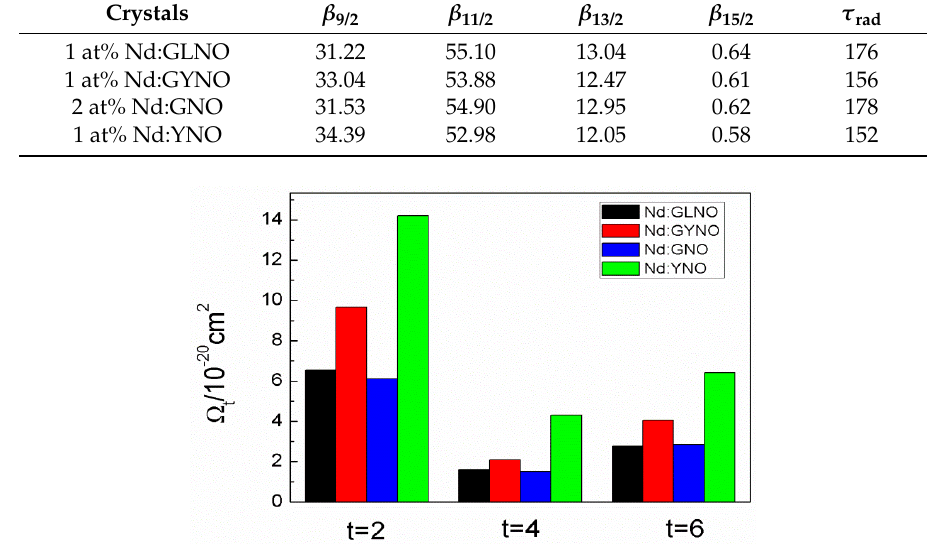
Figure 6. Comparison of Ω 2,4,6 between Nd:GNO, Nd:YNO, Nd:GYNO, and Nd:GLNO crystals.